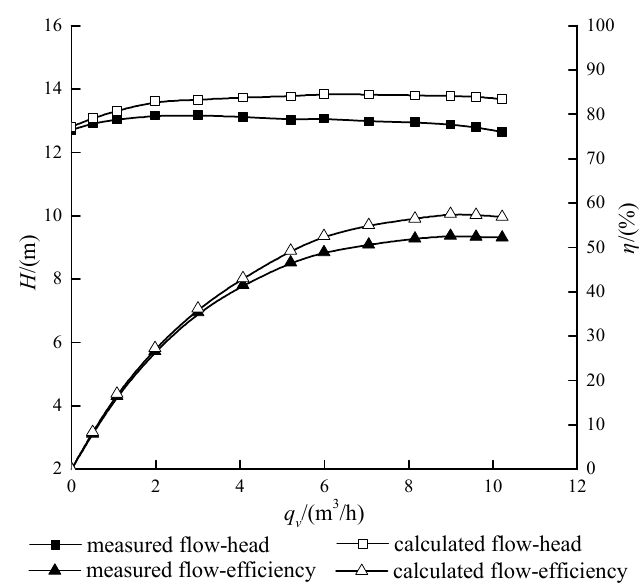
Figure 11. Performance comparison between experiments and simulation.